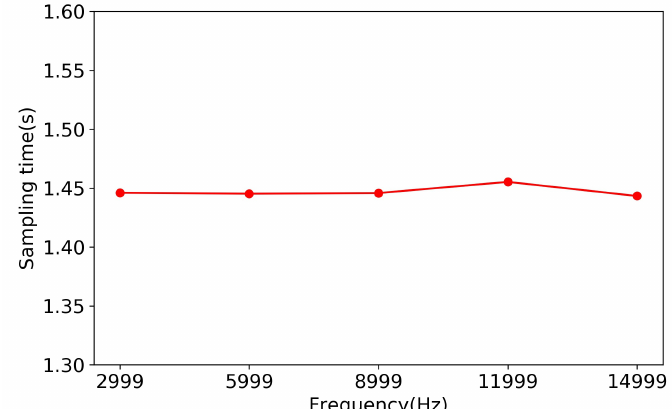
Figure 5. Sampling time at different